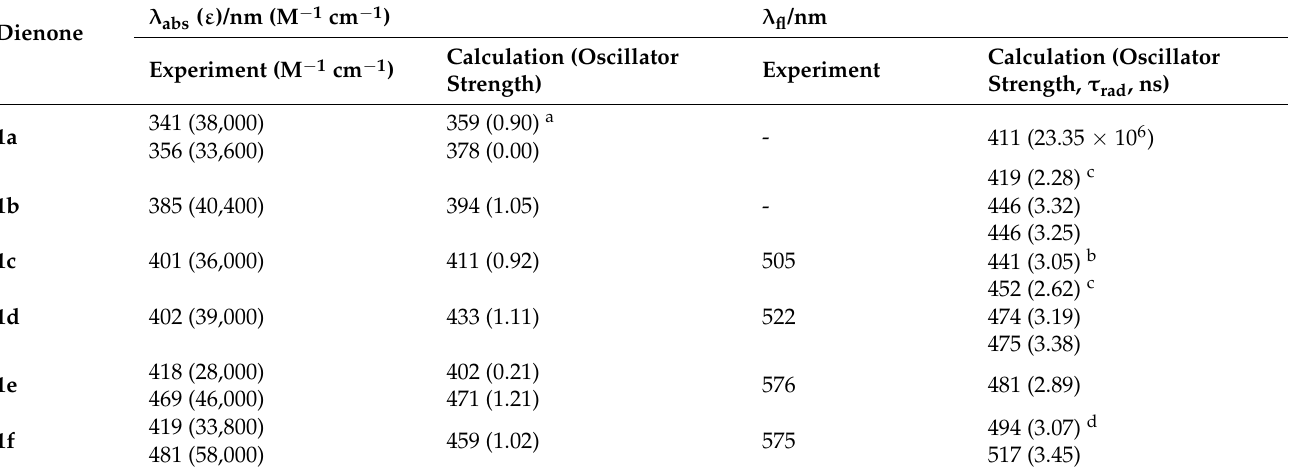
Table 4. Parameters of the electronic absorption and fluorescence spectra of dienones 1a – f , MeCN.